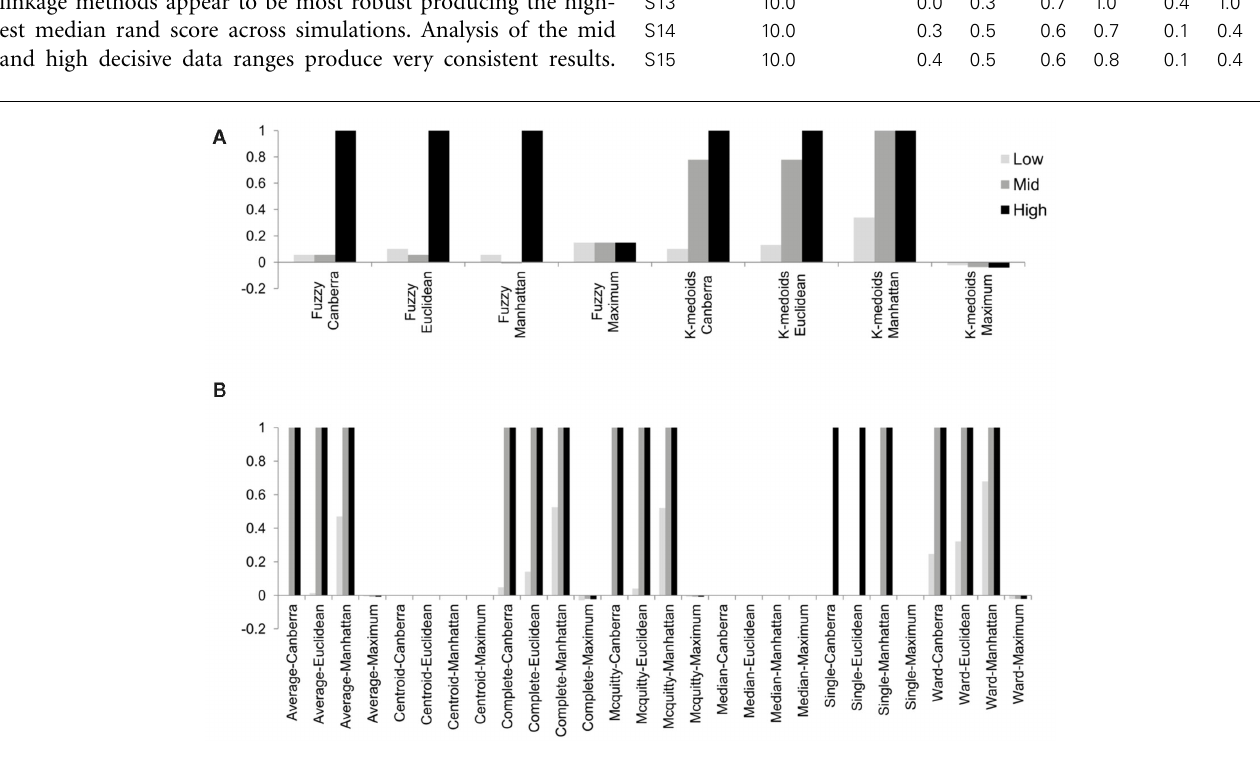
approaches. For clarity the data was combined into three groups, low (0.1 and 0.5% decisive data), mid (1% decisive data), and high (5 and 10% decisive